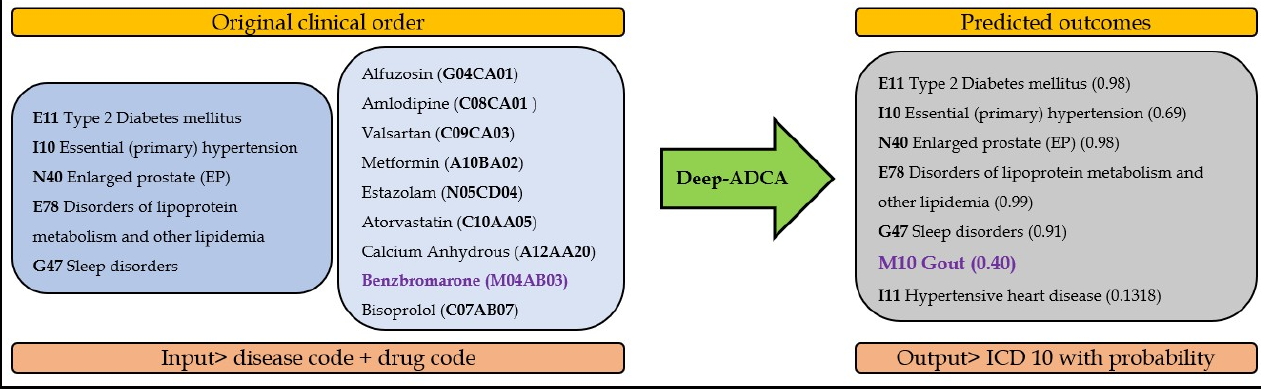
Figure 8. Prediction of missing diagnosis based on input drug.